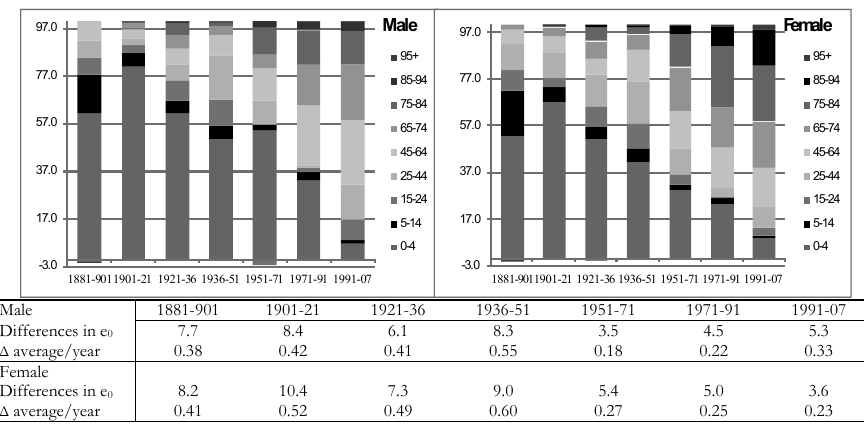
Figure 5 – Percentage contributions of different age groups to the increase in life expectancy for men and women in different time